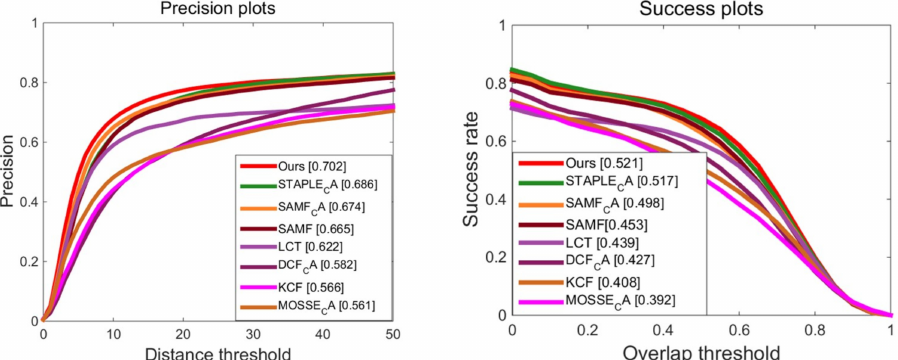
Figure 7. The overall results of distance precision and overlap success plots comparing the proposed tracker with state-of-the-art CF based trackers on Temple Color dataset using